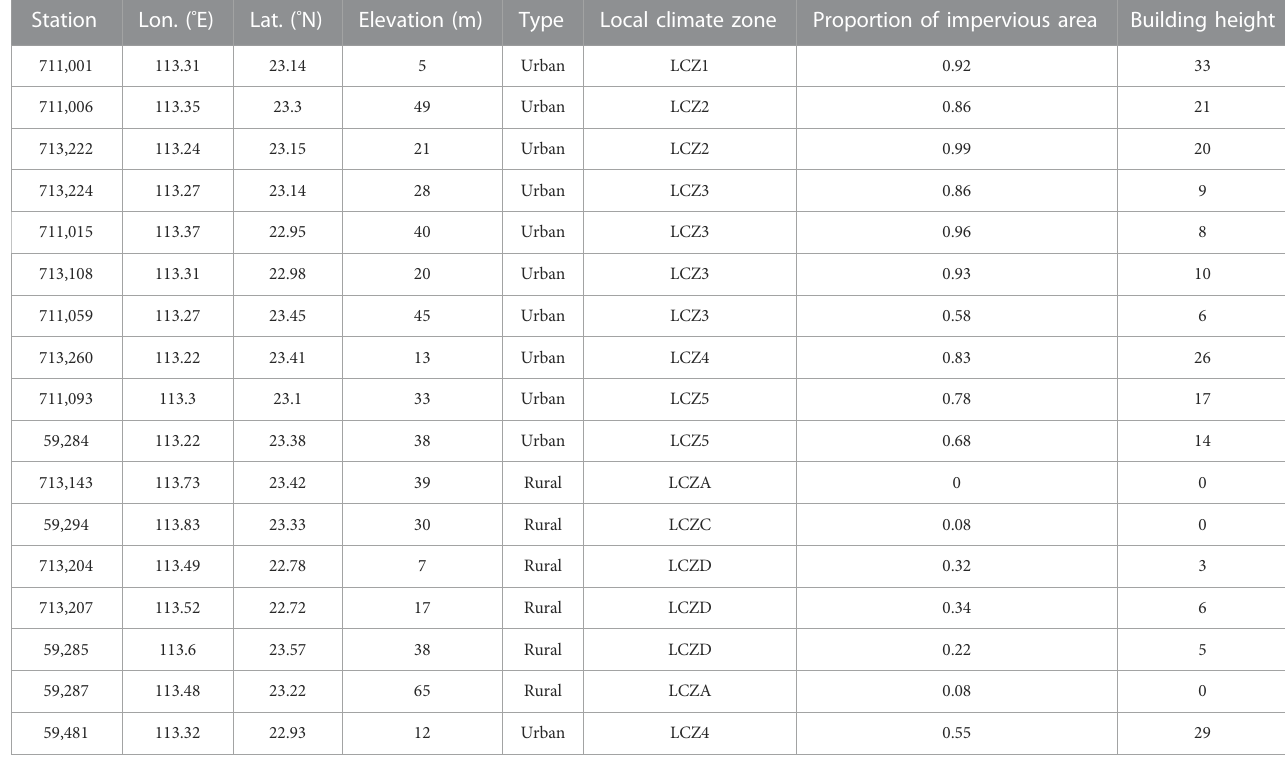
TABLE 1 Geographical location and classi fi cation of each of the urban and rural stations.